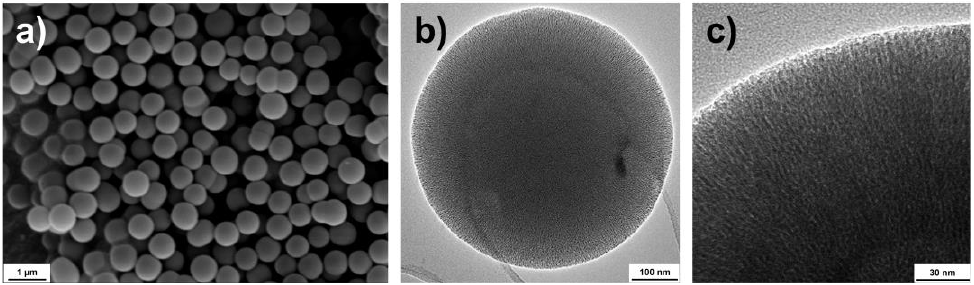
Figure 2. Scanning electron microscopy ( a ) and transmission electron microscopy ( b , c ) images of the spherical monodispersed nanocarriers.